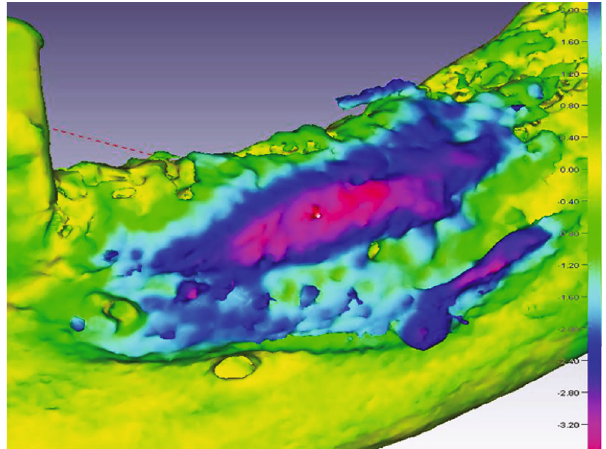
Figure 26: Graphical representation of the volume gain. The colour coding divides the gain from 0.0mm (yellow) to 4.0mm (red) at the respective positions of the third